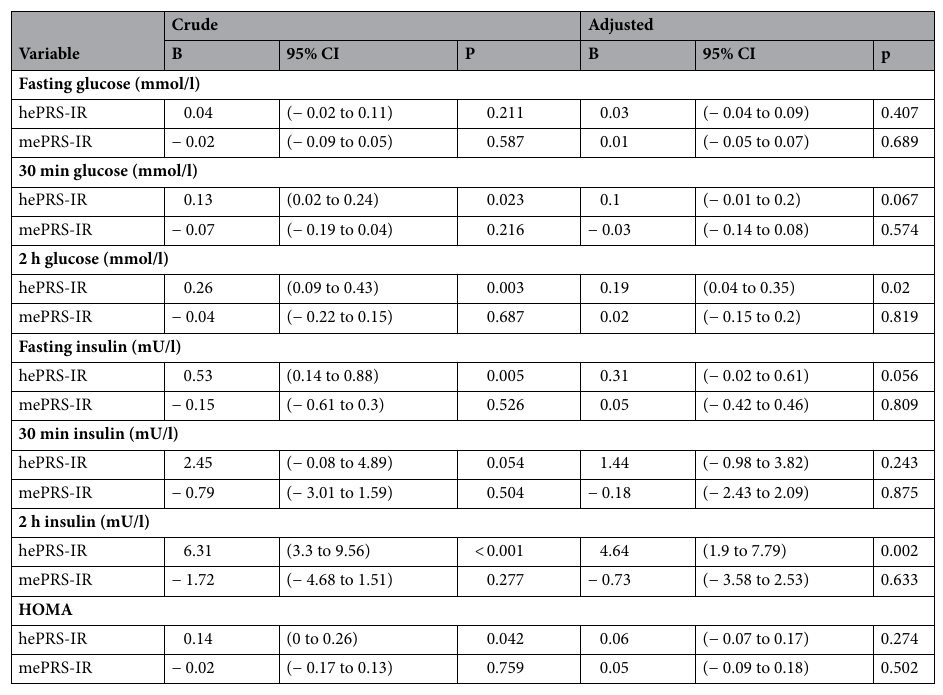
Table 6. The association between the hePRS-IR and mePRS-IR on markers of glucose and insulin metabolism and insulin resistance. Model 1 = adjusted for population stratification. Model 2 = adjusted for Model 1 + smoking, alcohol usage, socioeconomic status body mass index, leisure-time physical activity and comorbidities. hePRS-IR hippocampal biologically informed polygenic risk score for insulin receptor, mePRS-IR mesocorticolimbic biologically informed polygenic risk score for insulin receptor, B unstandardized regression coefficient. Confidence intervals and P values were based on the bootstrap style method of 10,000 repetitions.